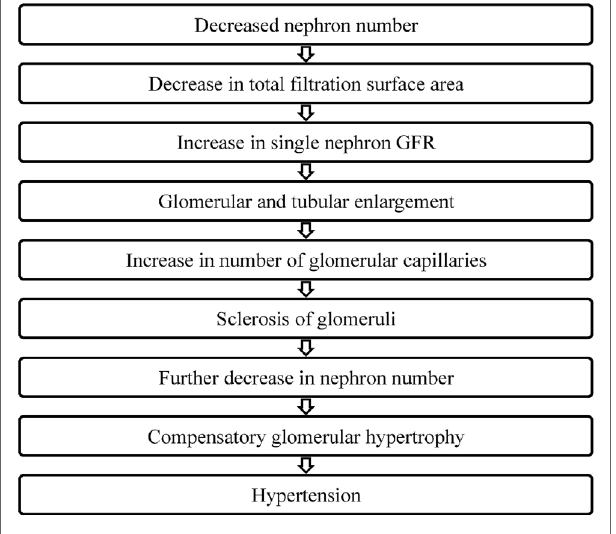
FigURe 2 | How does nephron number lead to